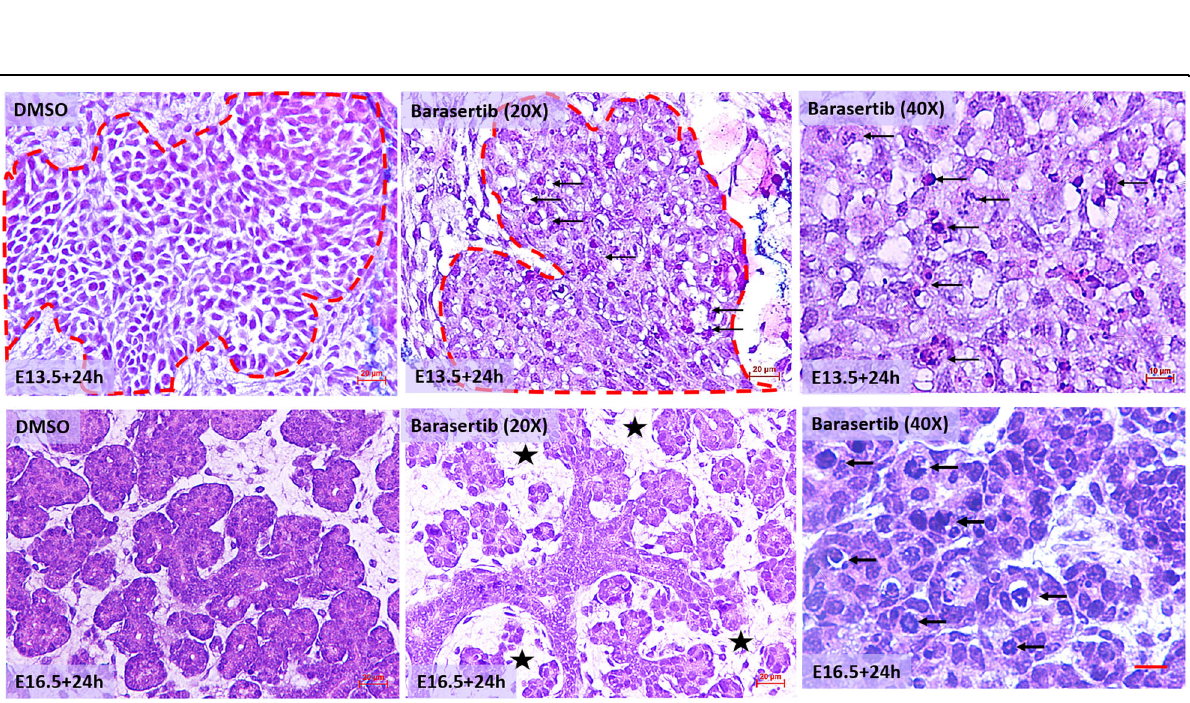
Fig. 4 H&E staining of E13.5 + 24 h (epithelial buds are outlined in red dotted line) and E16.5 + 24 h glands treated with DMSO or Barasertib. Low magni fi cation images show hypocellularity and increased mesenchymal spaces (asterisk) between the developing epithelia in the mature explants (E16.5 + 24 h), scale bar = 20 µm. High magni fi cation images show abundant, enlarged, hyperchromatic nuclei in response to AURKB inhibition during early (E13.5 + 24 h) and late (E16.5 + 24 h) embryonic development (arrows), scale bar = 10